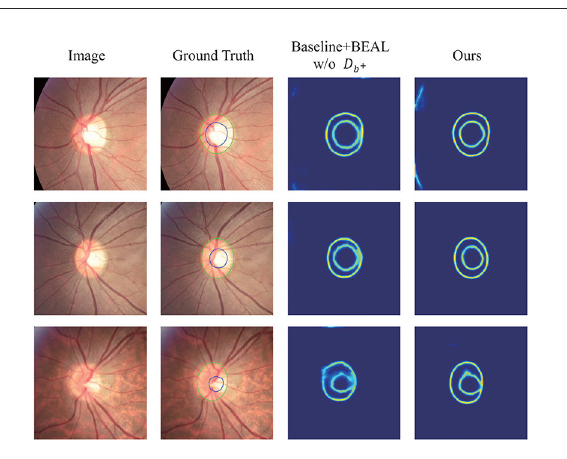
FIGURE6 Testing the impact of the overall CAE module on the boundary prediction map on